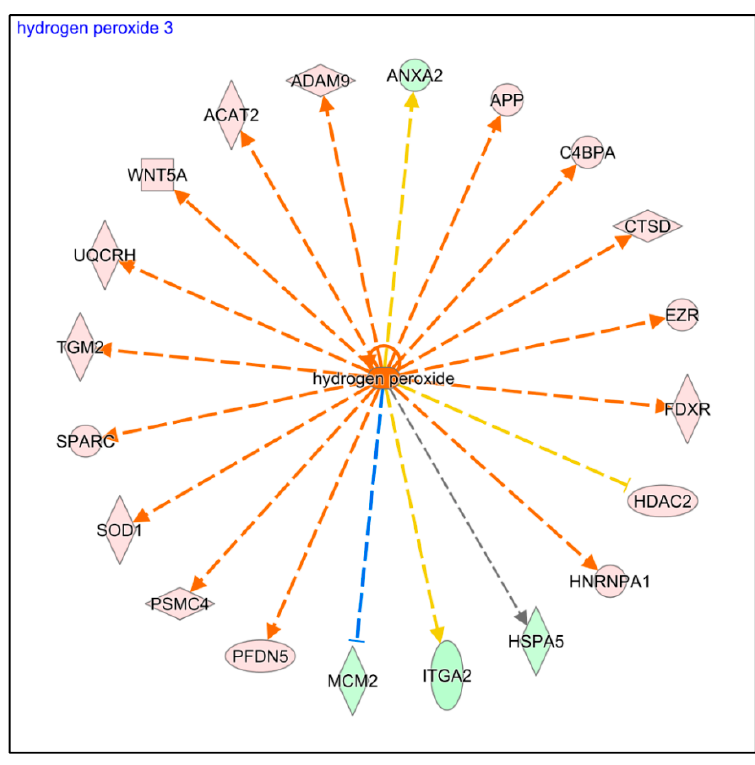
Figure 6. IPA Comparison Analysis predicted hydrogen peroxide as a top upstream regulator for some protein differentially expressed in HK cells after AS treatment.